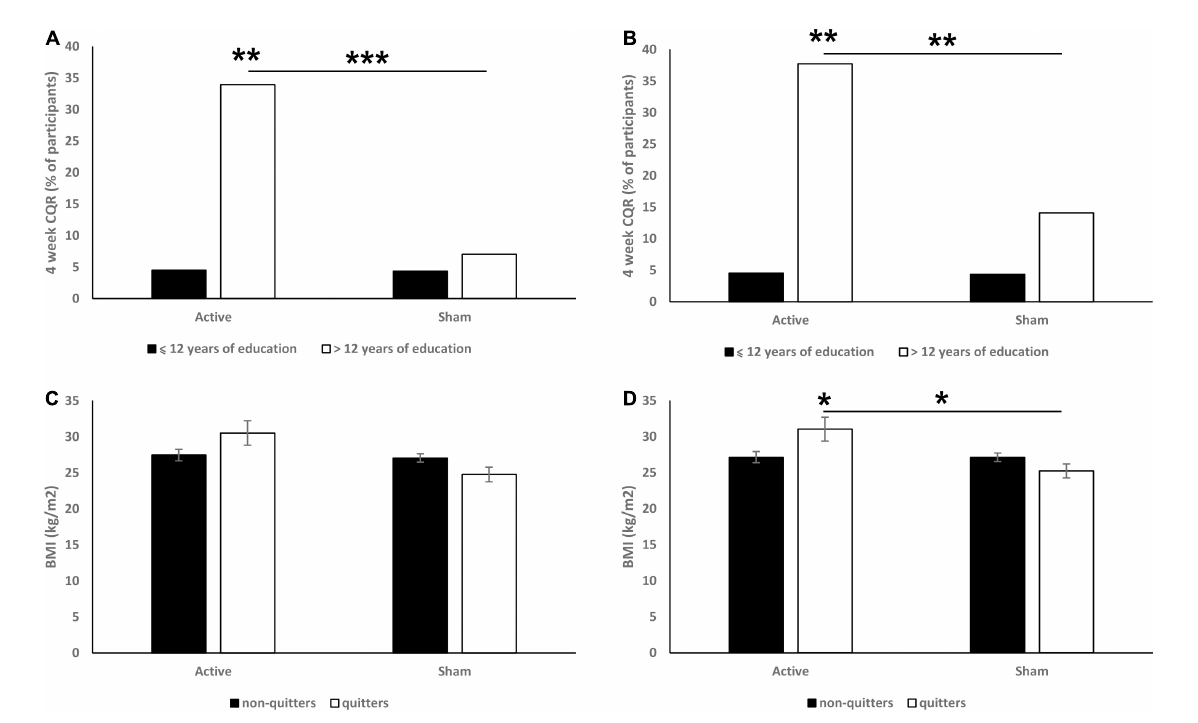
FIGURE2 Effects of education ( A: 6 weeks CQR data, B: 18 weeks CQR data) and BMI ( C: 6 weeks CQR data, D: 18 weeks CQR data) on CQR. On panels (A,B) data are presented as % of participants. On panels (C,D) data are presented as mean ± SEM. * p < 0.05, ** p < 0.01, *** p < 0.001.